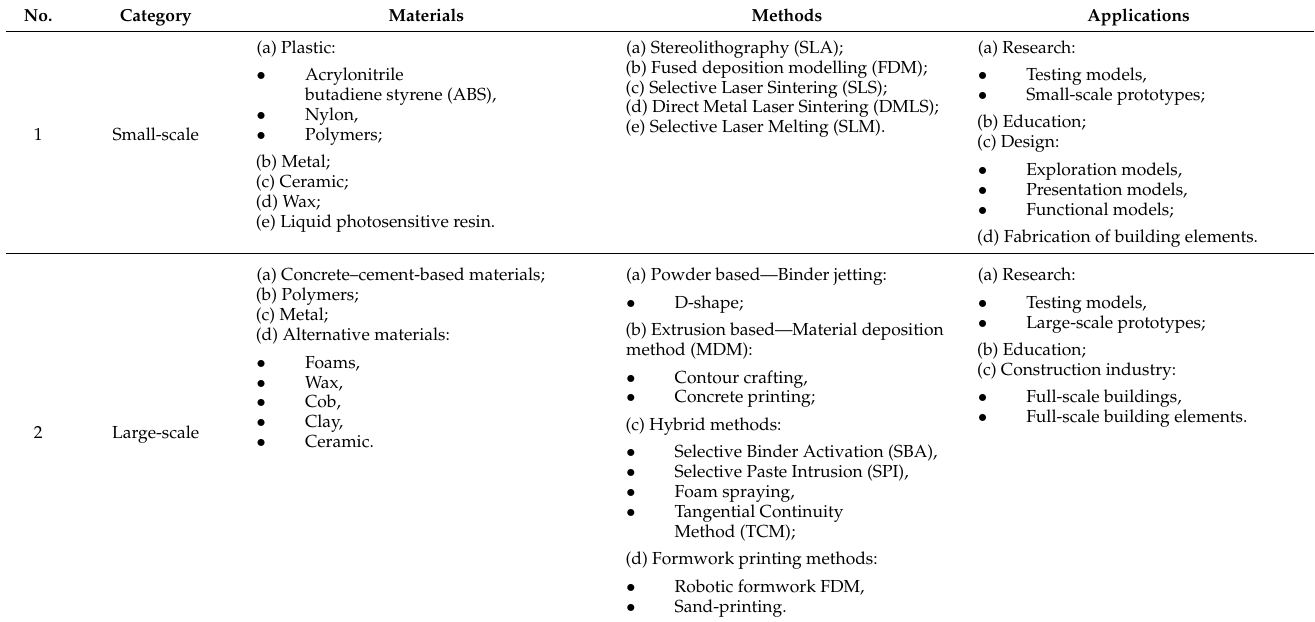
Table 5. Materials, methods, and applications of 3DP systems categories based on